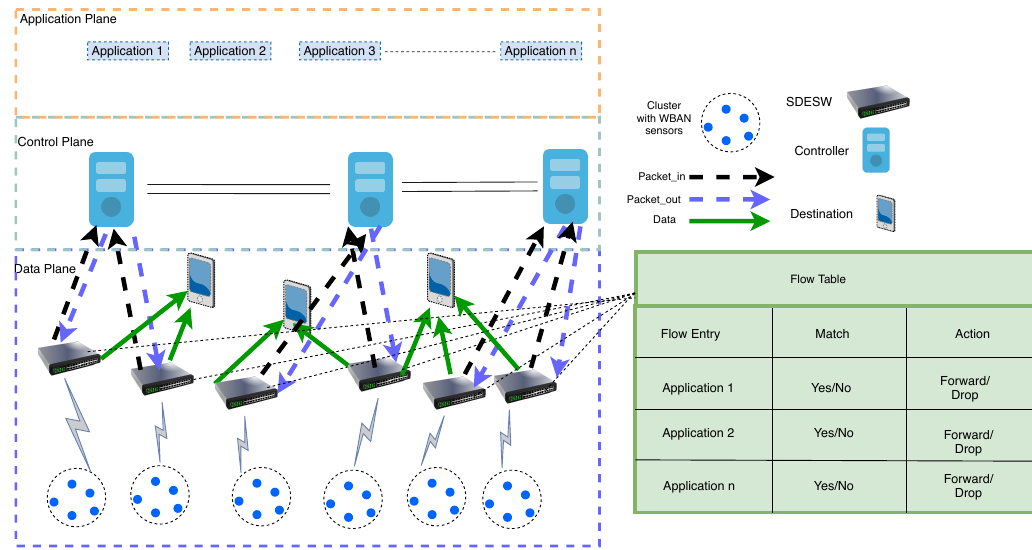
Figure 1. SDWBAN